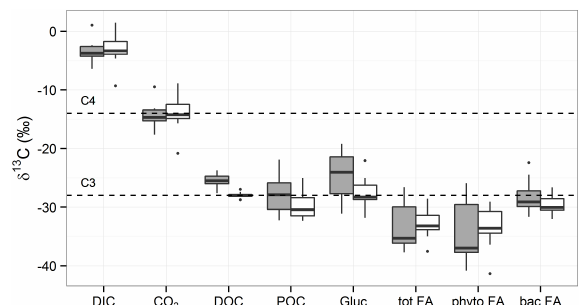
Figure 2. Box and whisker plot of the δ 13 C of inorganic and organic carbon pools in eutrophic lakes (grey boxes, n = 11) and oligo- mesotrophic lakes (white boxes, n = 11). The dashed lines present typical values for C 3 and C 4